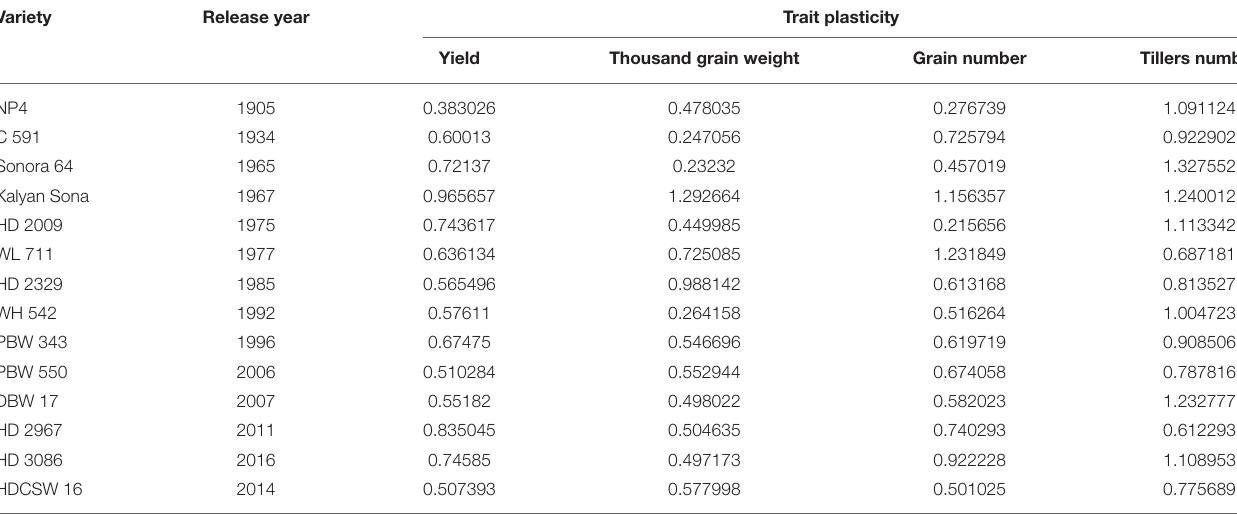
TABLE 3 | Trait plasticity in the genotypes released over the last 100 years.